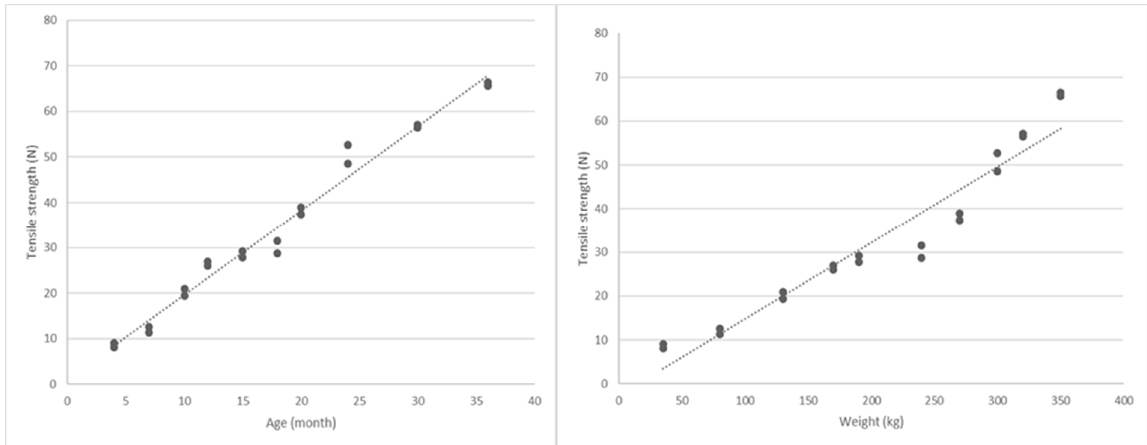
Figure 3. The left graph shows the correlation between age and tensile strength in the pooled sample; the right graph shows the correlation between weight and tensile strength in the pooled sample. A significantly strong correlation was found (R = 0.99 and R = 0.96, respectively ( p < 0.05)).